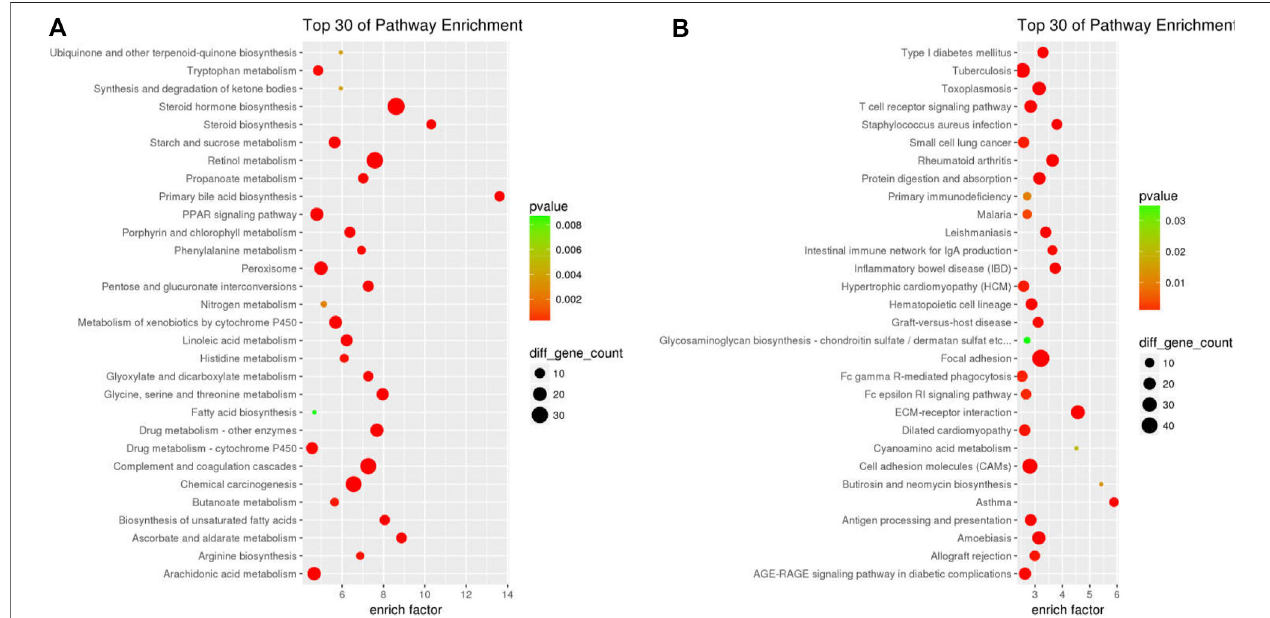
FIGURE 4 | PPI network of the DEGs resulting from GDFMD treatment of WD. Node sizes correlate with node degree; The higher expression genes in WD group that compared with CN and GDFMD group were performed pink nodes, The lower expression genes in WD group that compared with CN and GDFMD group were performed green nodes; PPI, protein-rotein interaction; DEGs, differentially expressed